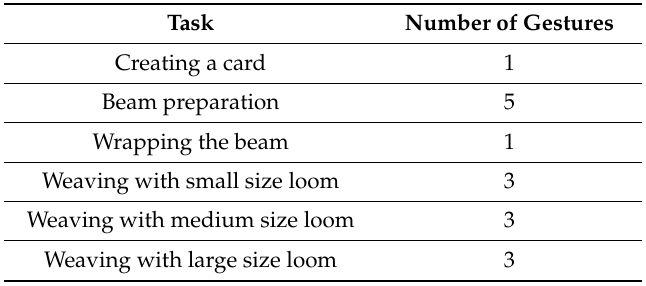
Table 1. Multimodal gestures vocabulary for weaving.